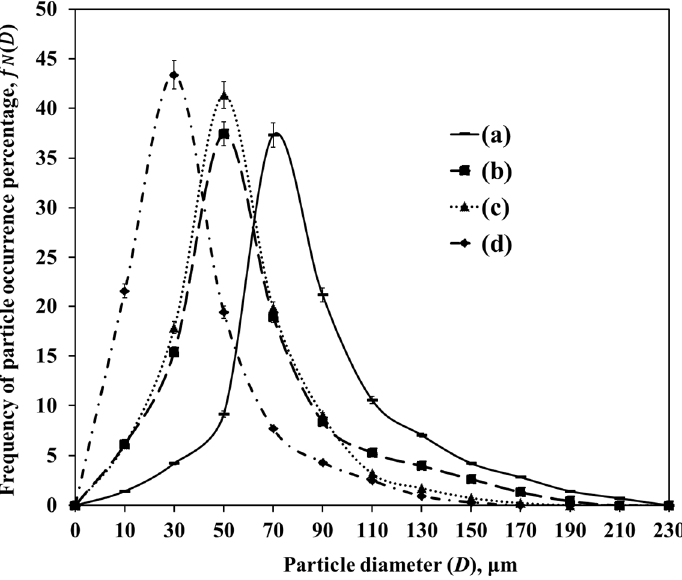
Figure A5. Particle diameter distributions of spray-dried 25SA products calcined at 550 °C, obtained at the following rotational speeds of the curved rectangular vanes disk: ( a ) 3000 rpm (P1 – DAC), ( b ) 6000 rpm (P2 – DAC), ( c ) 11,500 rpm (P3 – DAC), and ( d ) 14,000 rpm (P4 – DAC).